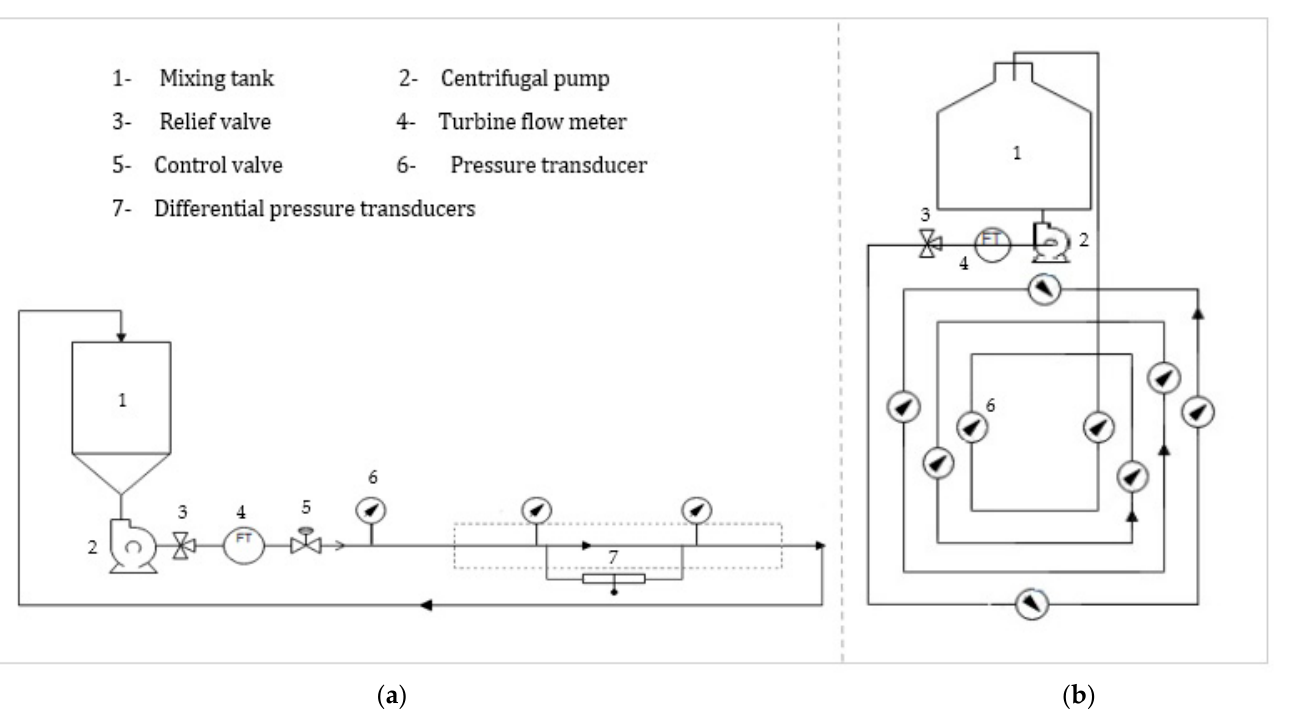
Figure 2. Experimental setup components and fl ow loops system. ( a ) Clear PVC open-loop re-circulating pipe with a diameter of 0.0762 m and a total length of 65 m. ( b ) PVC pipe with a diameter of 0.0191 m and a length of 22 m.